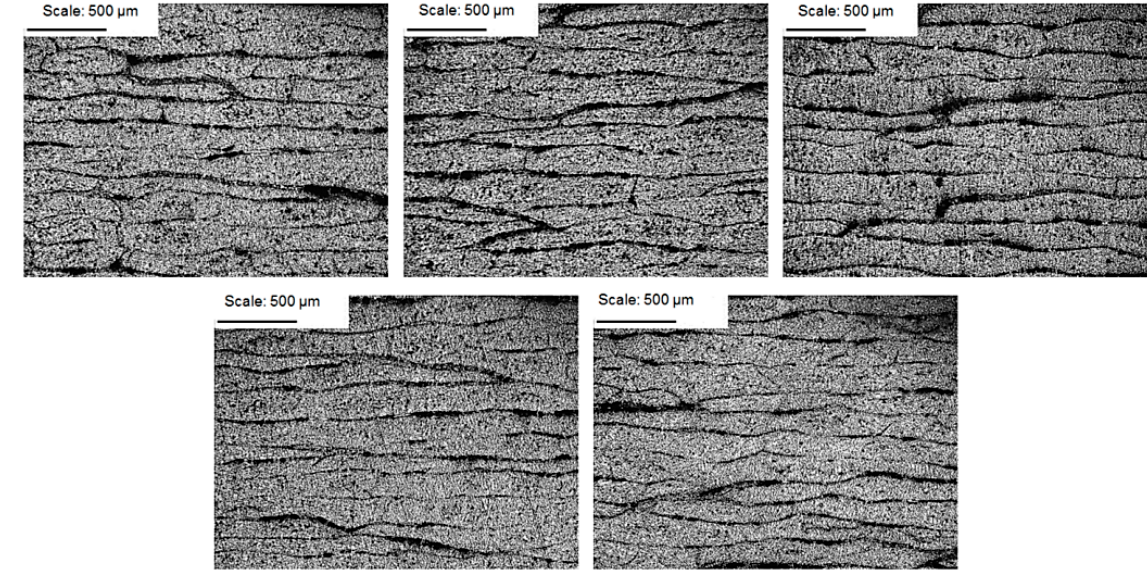
Figure 8. CFRP composite microstructure photomicrographs; magnification of 50× for samples 1–5.